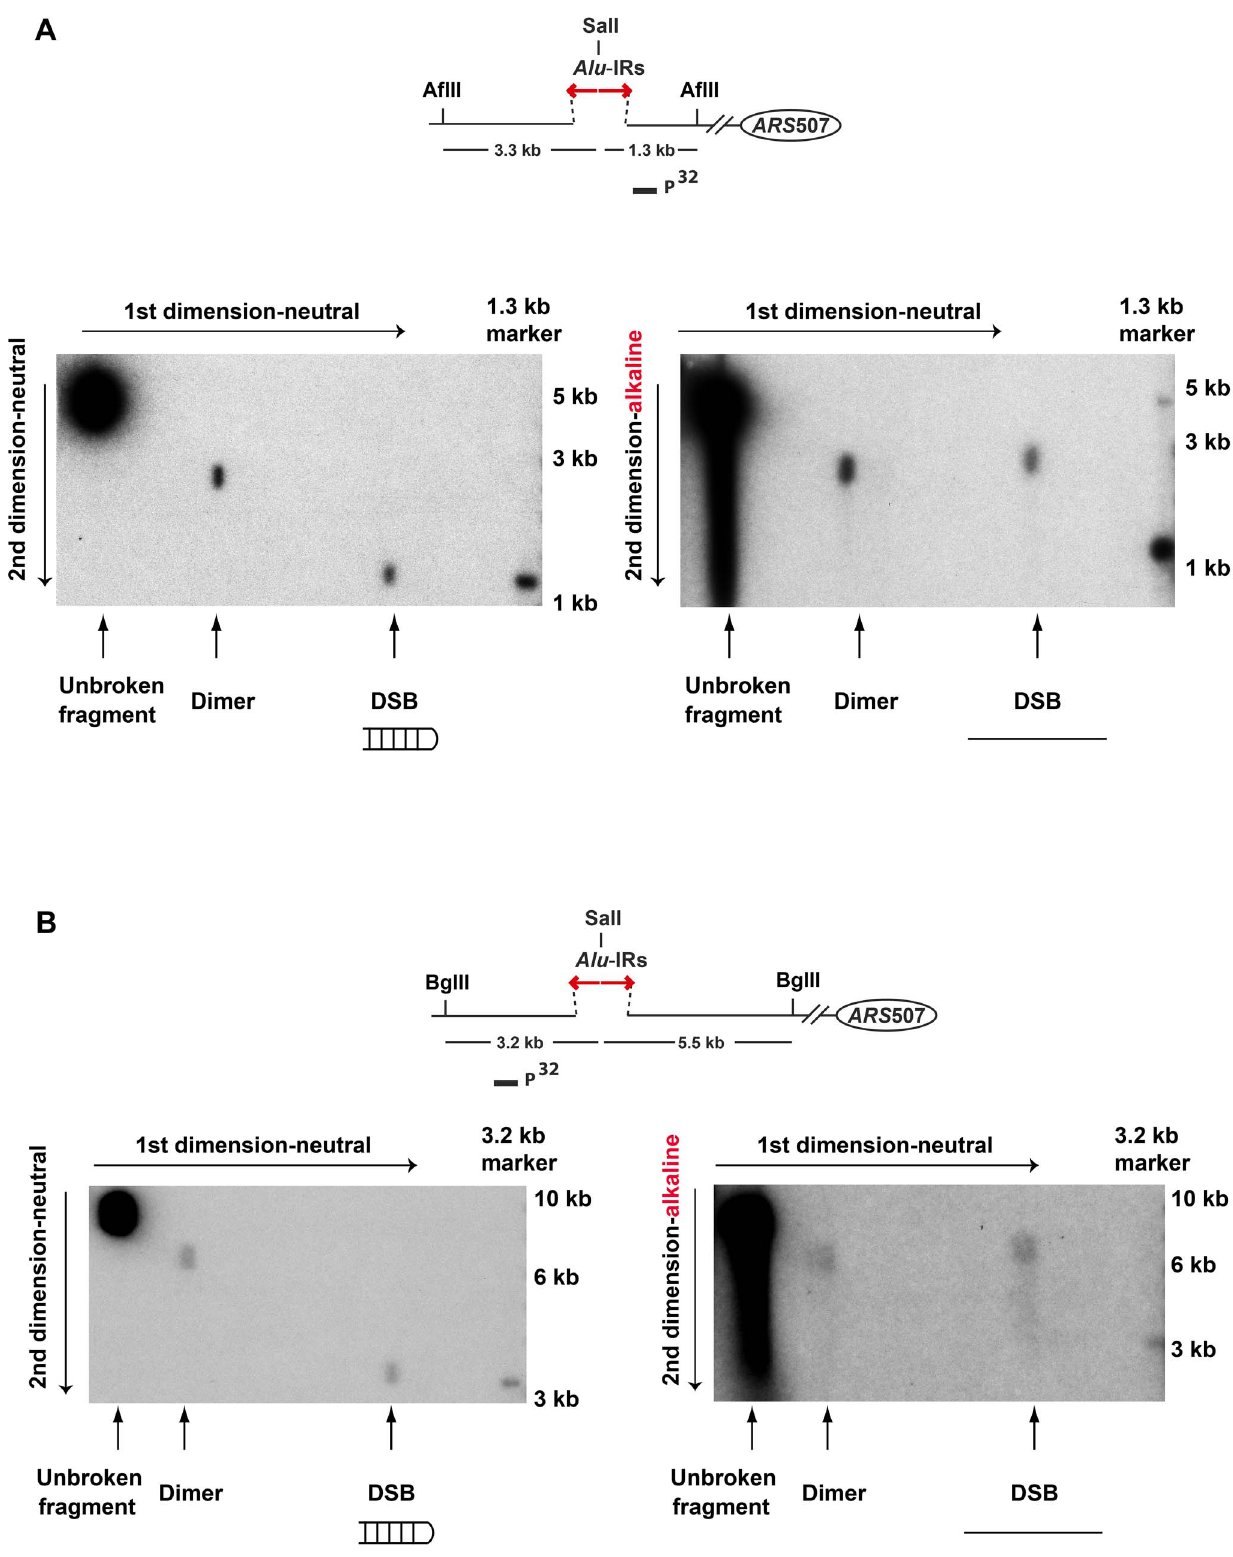
Figure 3. 2D neutral/alkaline gel analysis of Alu -IR-induced DSBs in theTET- POL3 D sae2 strain. Yeast DNA embedded in agarose plugs was digested with AflII ( A ) or BglII ( B ). Digested DNA was separated in neutral conditions in the first dimension. In the second dimension, DNA was run in either neutral (left gel) or alkaline (right gel) conditions. Southern hybridization was done as described in Figure 2.